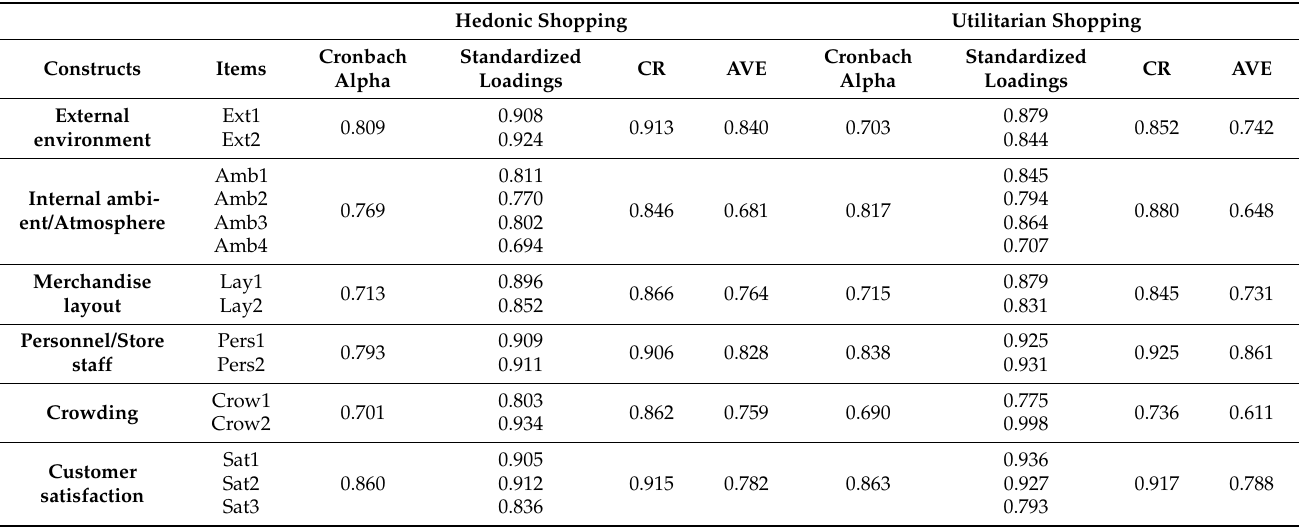
Table 2. Factor loadings and indicators of internal consistency and reliability. Hedonic Shopping